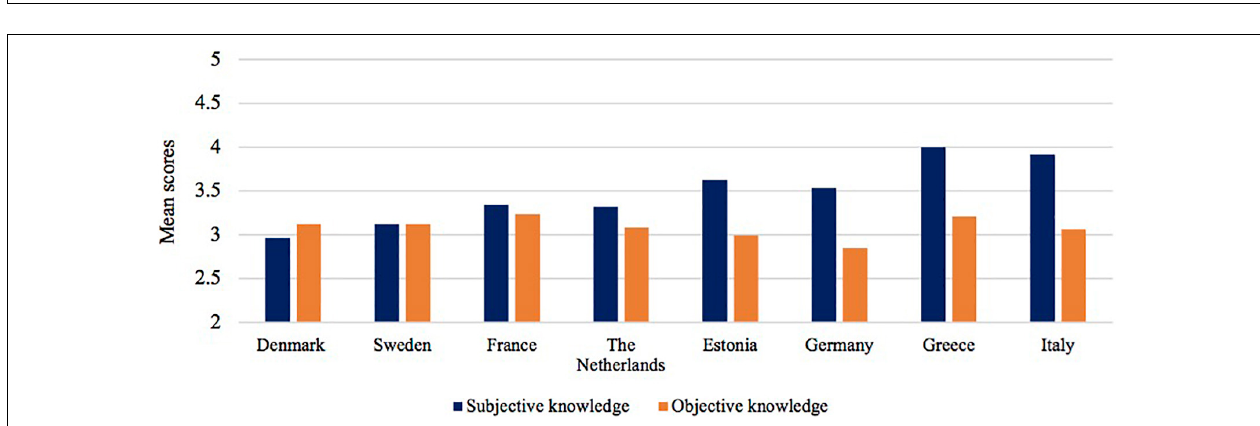
FIGURE 8 | Mean scores for respondents’ subjective and objective knowledge of marine plastic litter across countries. Scores range from 1 = low (self-perceived) knowledge to 5 = high (self-perceived)